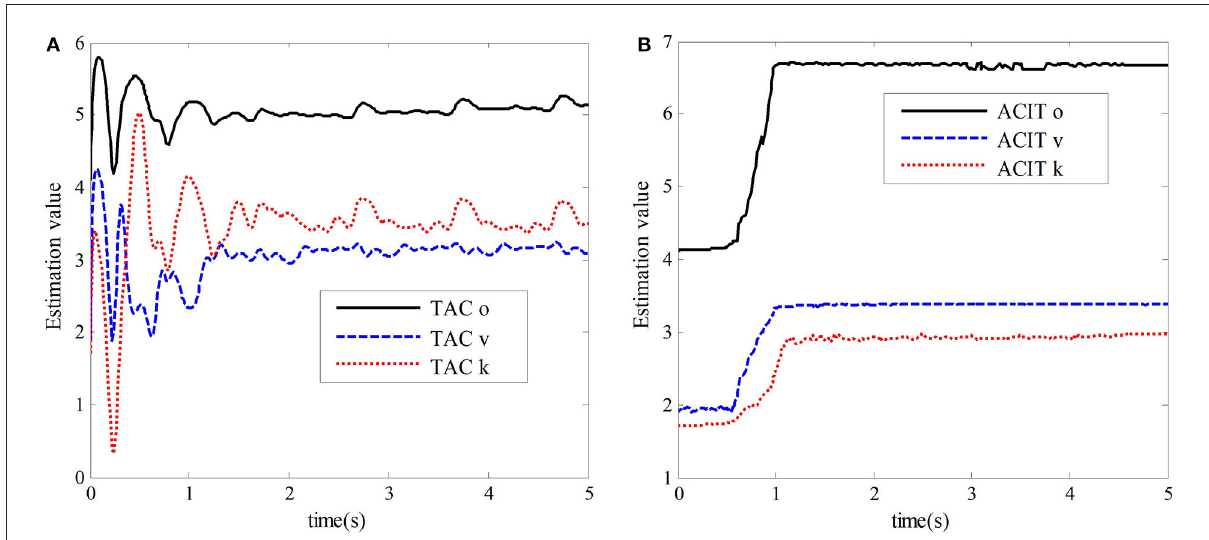
FIGURE6 Estimated values of the dynamic parameter vector. (A) The estimated value of TAC. (B) The estimated value of